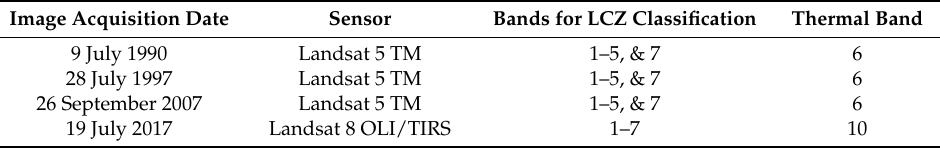
Table 1. Description of Landsat images that were used in this